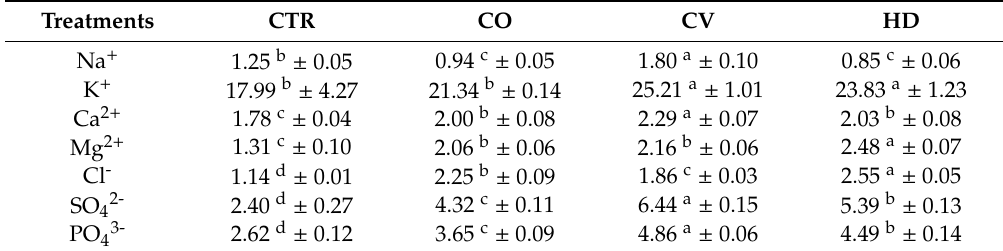
Table 1. Ion content (mg g − 1 dw) in red Topepo fruits grown in unfertilized soil (control, CTR) and soils fertilized with compost from olive wastes (CO), compost from vegetable wastes (CV), and horse dung (HD).